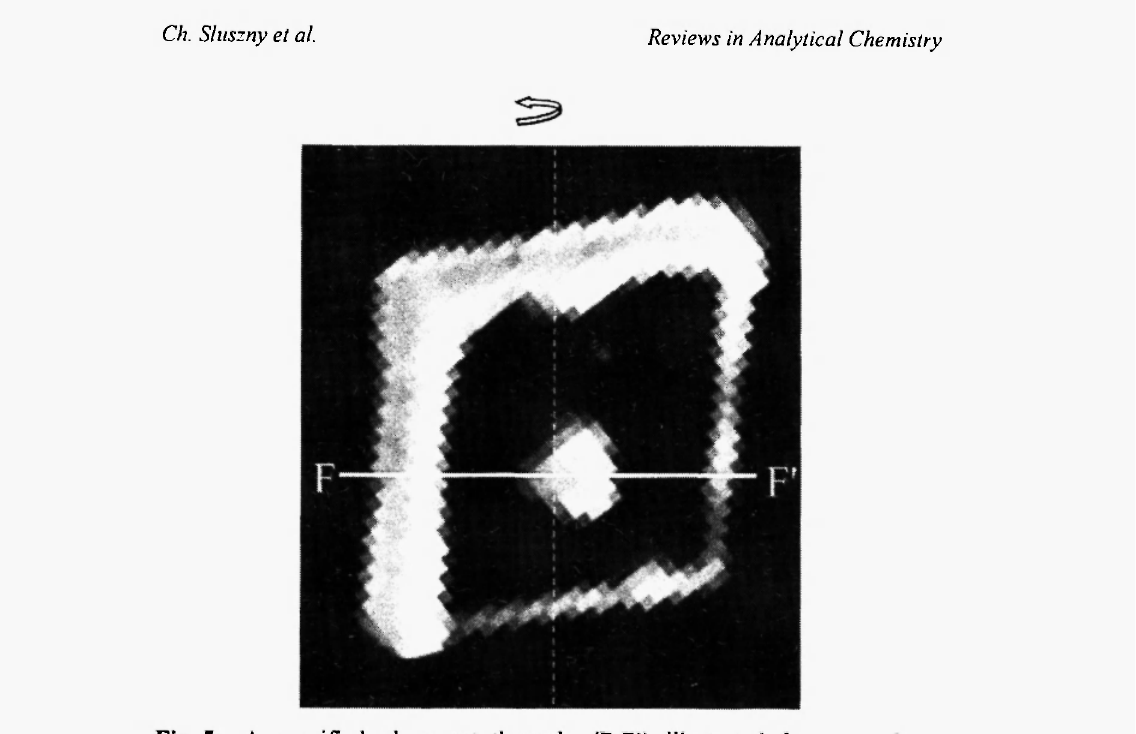
Fig. 5: A specified plane cut through, (F-F') illustrated for a perylene crystal. The arrow indicates the rotation axis.